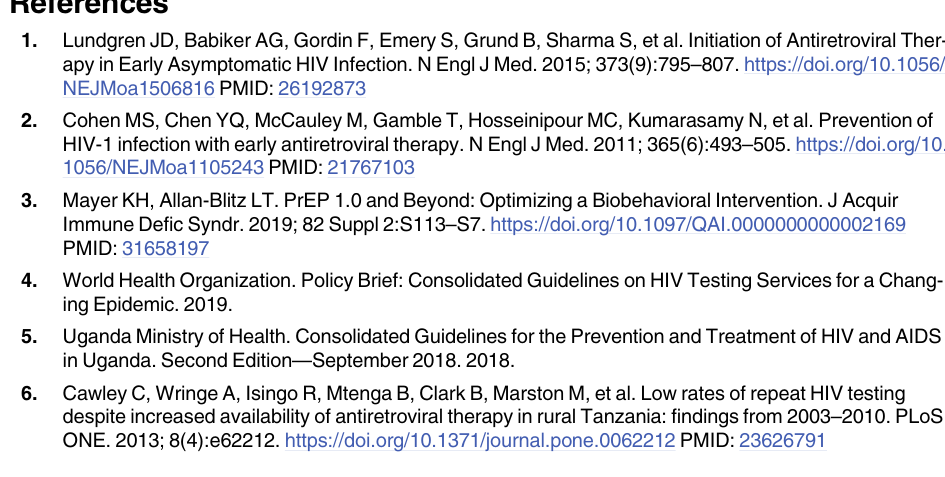
S1 Table. Instrumental variable regression results to estimate causal effect of making a deposit on HIV